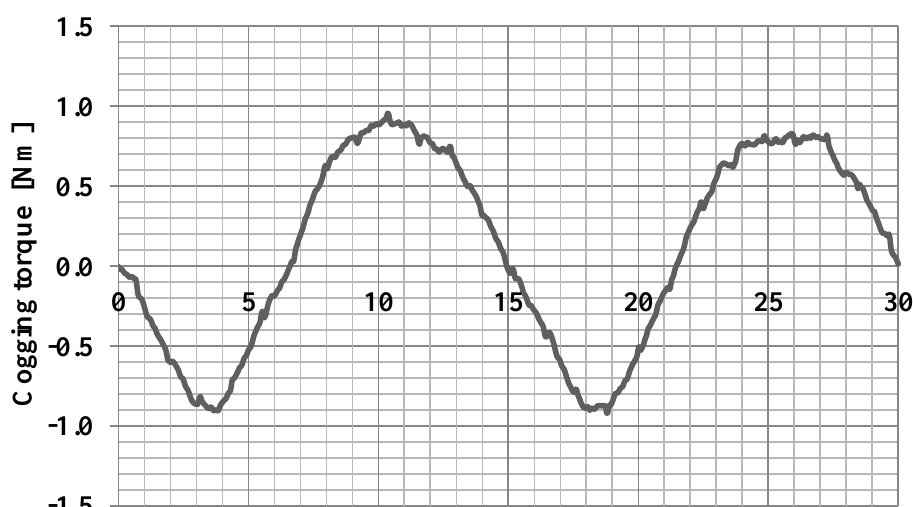
Figure 14. The cogging torque characteristic of the